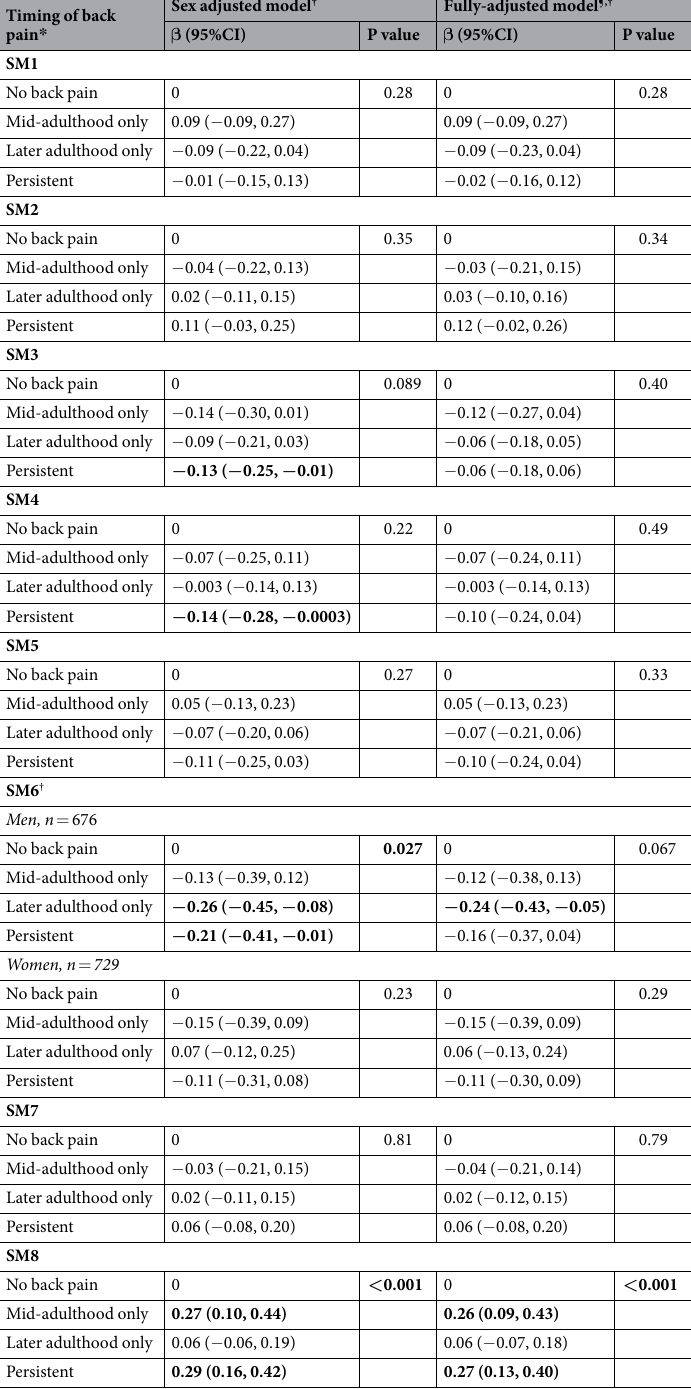
Table 4. Associations between timing of back pain and spine modes (N = 1405). SM: spine mode. * Mid- adulthood only: back pain reported at age 36 and/or 43 years only; Later adulthood only: back reported at age 53 and/or 60–64 years only; Persistent: Back reported in both mid and later adulthood. † Combined analyses presented except for mode 6 which was sex-stratified, sex interaction, p = 0.048 (unadjusted model); ¶ adjusted for sex, current BMI, spine aBMD, own occupational class, physical activity, GHQ-28 and number of